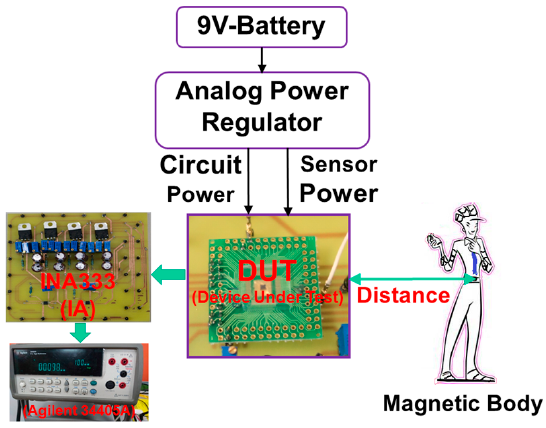
Figure 4. Experimental setup of distance detection.